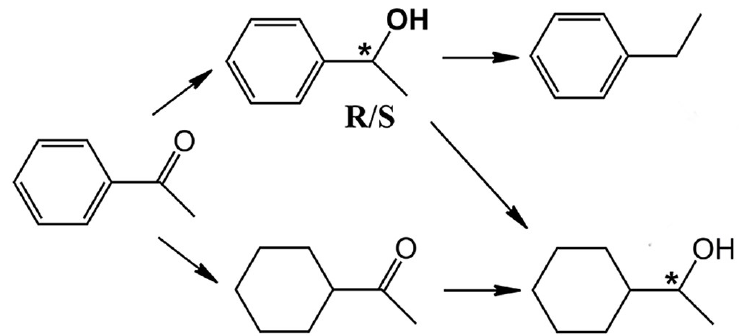
Figure 5. Cyclic voltammograms at a scanning rate of 50 mV s −1 measured on a glass carbon electrode modified with P25@Pd core-shell catalyst in a 0.5 M H 2 SO 4 solution.